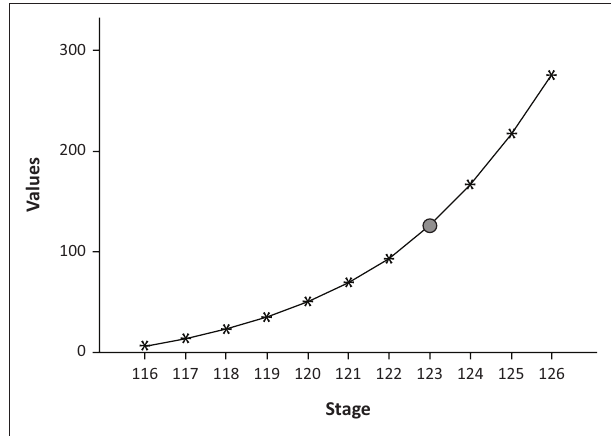
FIGURE 3: Agglomeration curve: as the ‘step of elbow’ shown by a big black dot appears to be at case number 123, a four-cluster solution should be used (i.e. 127 - 123 = 4). TABLE 4: Number of ecosystem service users occupying each cluster type. Cluster type